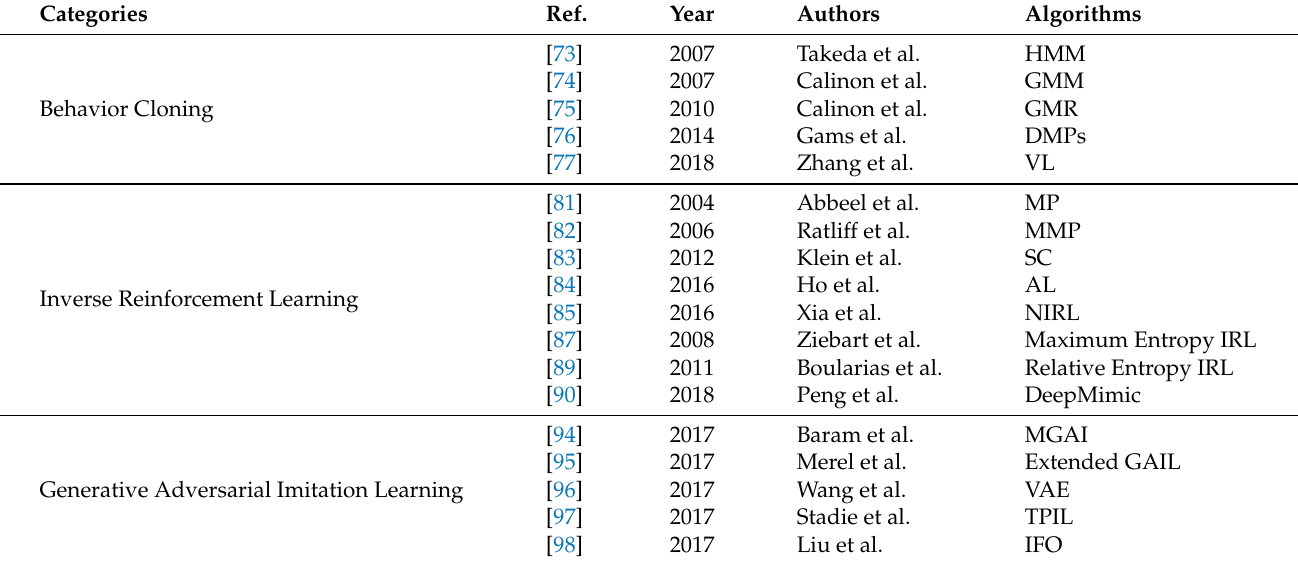
Table 2. Robot algorithms based on imitation